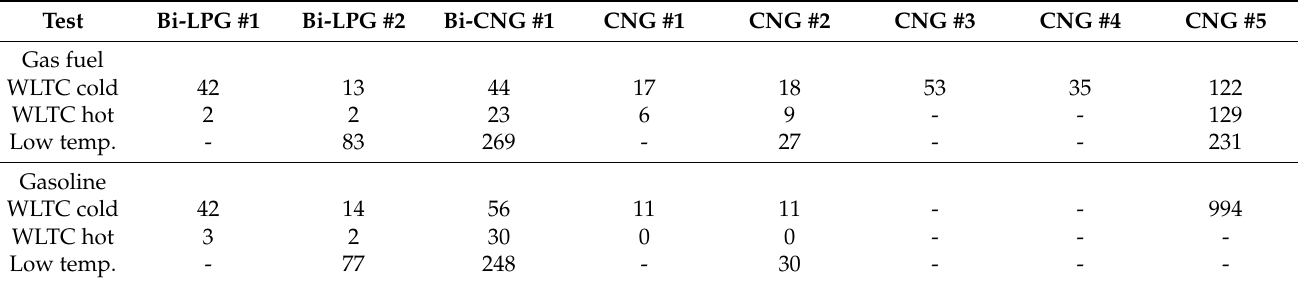
Table 2. Total hydrocarbons (THC) emissions (in mg/km) in the laboratory (no data for on-road tests). Dashed lines mean that no measurements are available.